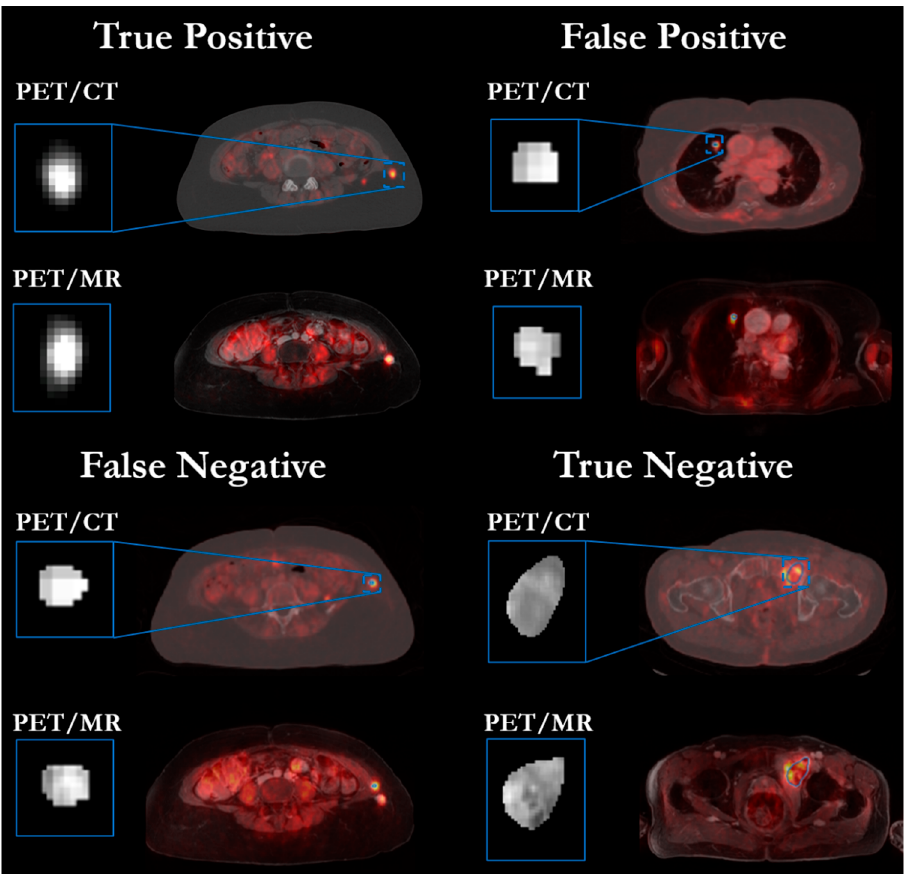
Figure 6. PET/MR and PET/CT images of four patients based on their CNN risk-classification output towards a true positive (true low risk), false positive (predicted low risk, but high-risk target), false negative (predicted high risk, but low-risk target) and true negative (true high risk). The PET images are color-coded overlaid to the CT/MR images. A zoomed version of the PET lesion is depicted to appreciate the textural inhomogeneity. The textural composition of the lesion guided the risk pre- diction.